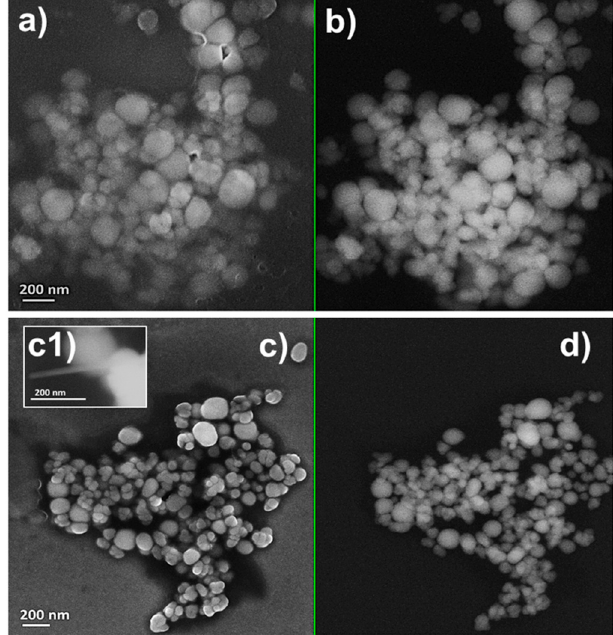
Figure 4. Scanning electron micrographs of ( a , b ) SeNPs MPV1-5_120_e and ( c , d ) SeNPs MPV1-10_120_e recovered from MPV1 cells grown for 120 h in the presence of 5 mM (( a ) InLens detector and ( b ) backscattered electron detector) or 10 mM SeO 32- mM (( c ) InLens detector and ( d ) backscattered electron detector).